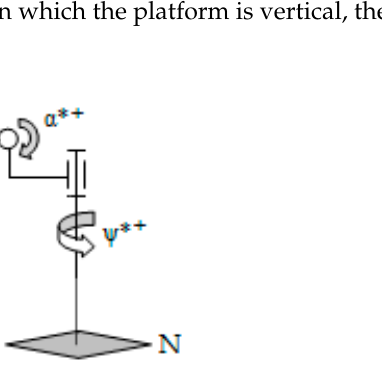
Figure 12. The orientation angles of a bi-axial azimuthal system (S—South, N—North). There are two way to ensure the sun tracking, with continuous movement or step-by- step. The ideal case is that of continuous orientation throughout the daylight, so that the normal to the platform coincides at all times with the direction of the sunray. To ensure the ideal incidence, the platform’s orientation angles must coincide with the sunray’s angles ( ψ * = ψ , α * = α ). For example, Figure 13 shows the incident radiation (coinciding with that of direct radiation) for continuous tracking (I) on the day of summer solstice, along with the curve corresponding to the fixed or stationary system (II), at which the platform is maintained throughout the entire day in the noon position ( ψ * = 0 ◦ ), at an elevation angle equal to that of the sunray at that time ( α * = 67.8 ◦